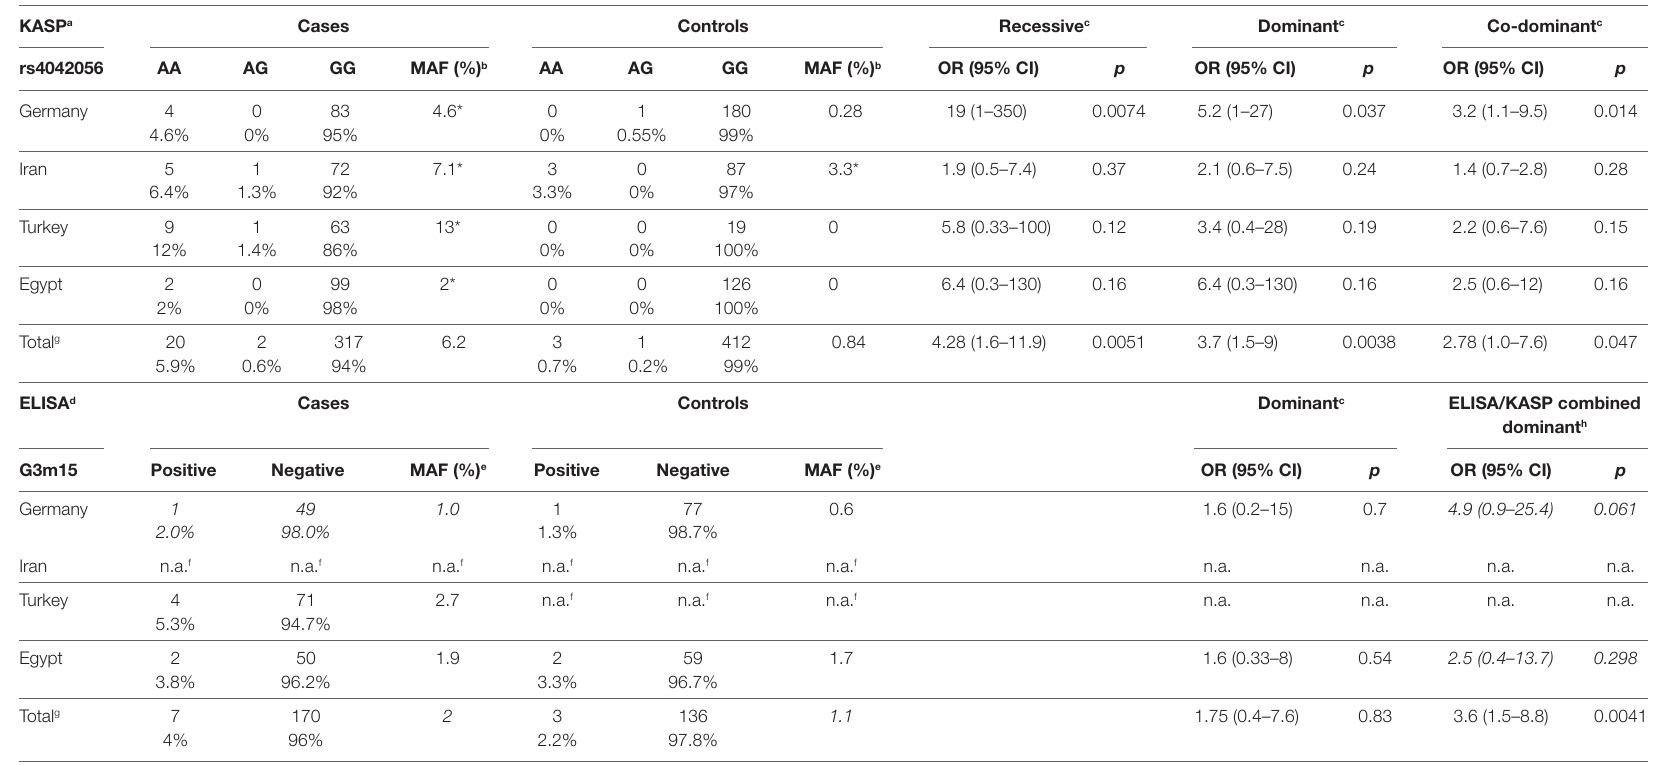
Table 1 | IgG3 rs4042056 variation in pemphigus vulgaris by KASP assay. KasP